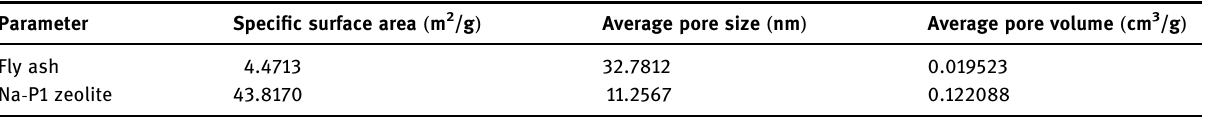
Table 3: Comparison of parameters of fl y ash and Na - P1 zeolite